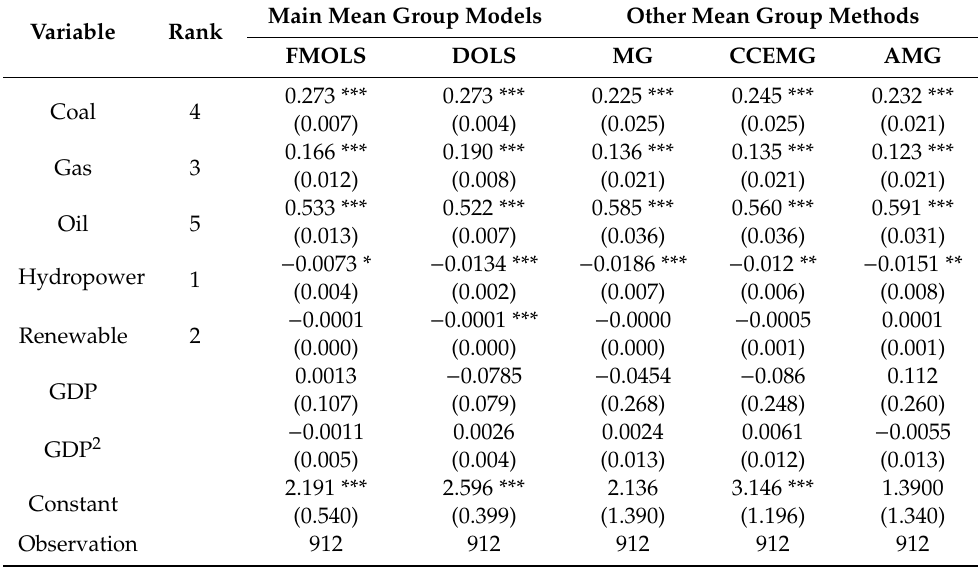
Table 7. Regression results for model 1 (dependent variable: lnCO 2 ).